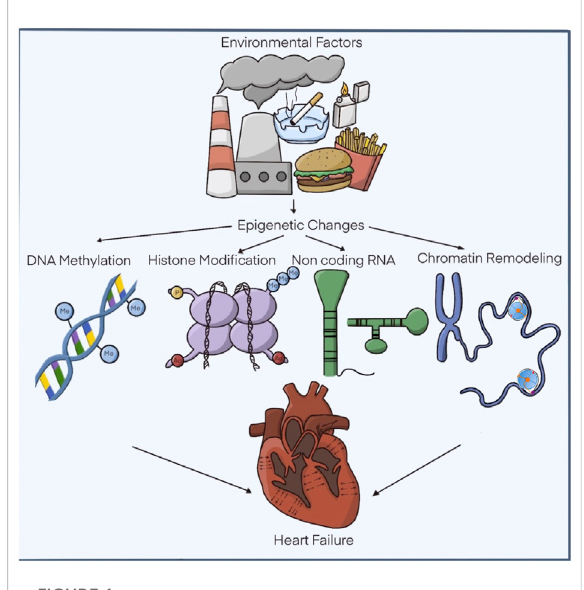
FIGURE 1 Epigenetic modi fi cations related to hypertrophic cardiomyopathy.Thefunctionalalterationsoftheheartaresubject to a series of external factors that in fl uence the recognized epigenetic modi fi cations. DNA methylation,